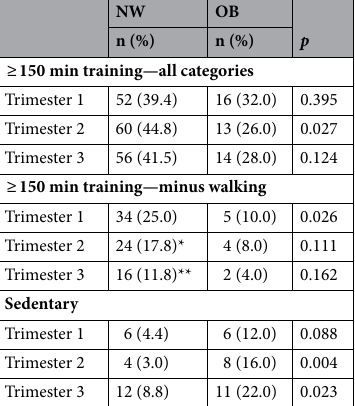
Table 2. Number of women reaching 150 min of exercise and number of women being sedentary. NW, women of normal weight; OB, women with obesity. p denotes significance between NW and OB using